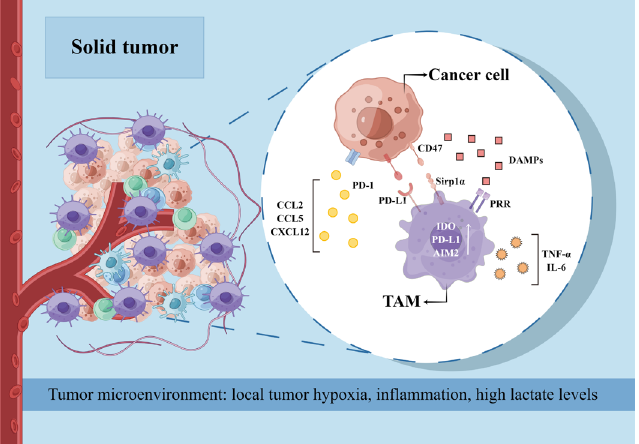
Figure 3. The role of TAMs in tumor progression and related mechanisms. PD-1: programmed cell death protein 1; PD-L1: PD-ligand 1; PRR: (pro)renin receptor; IDO: indoleamine-2,3-dioxygenase; AIM2: absent in melanoma 2; Sirp1α: signal regulatory protein 1 alpha. This figure was drawn by Figdraw